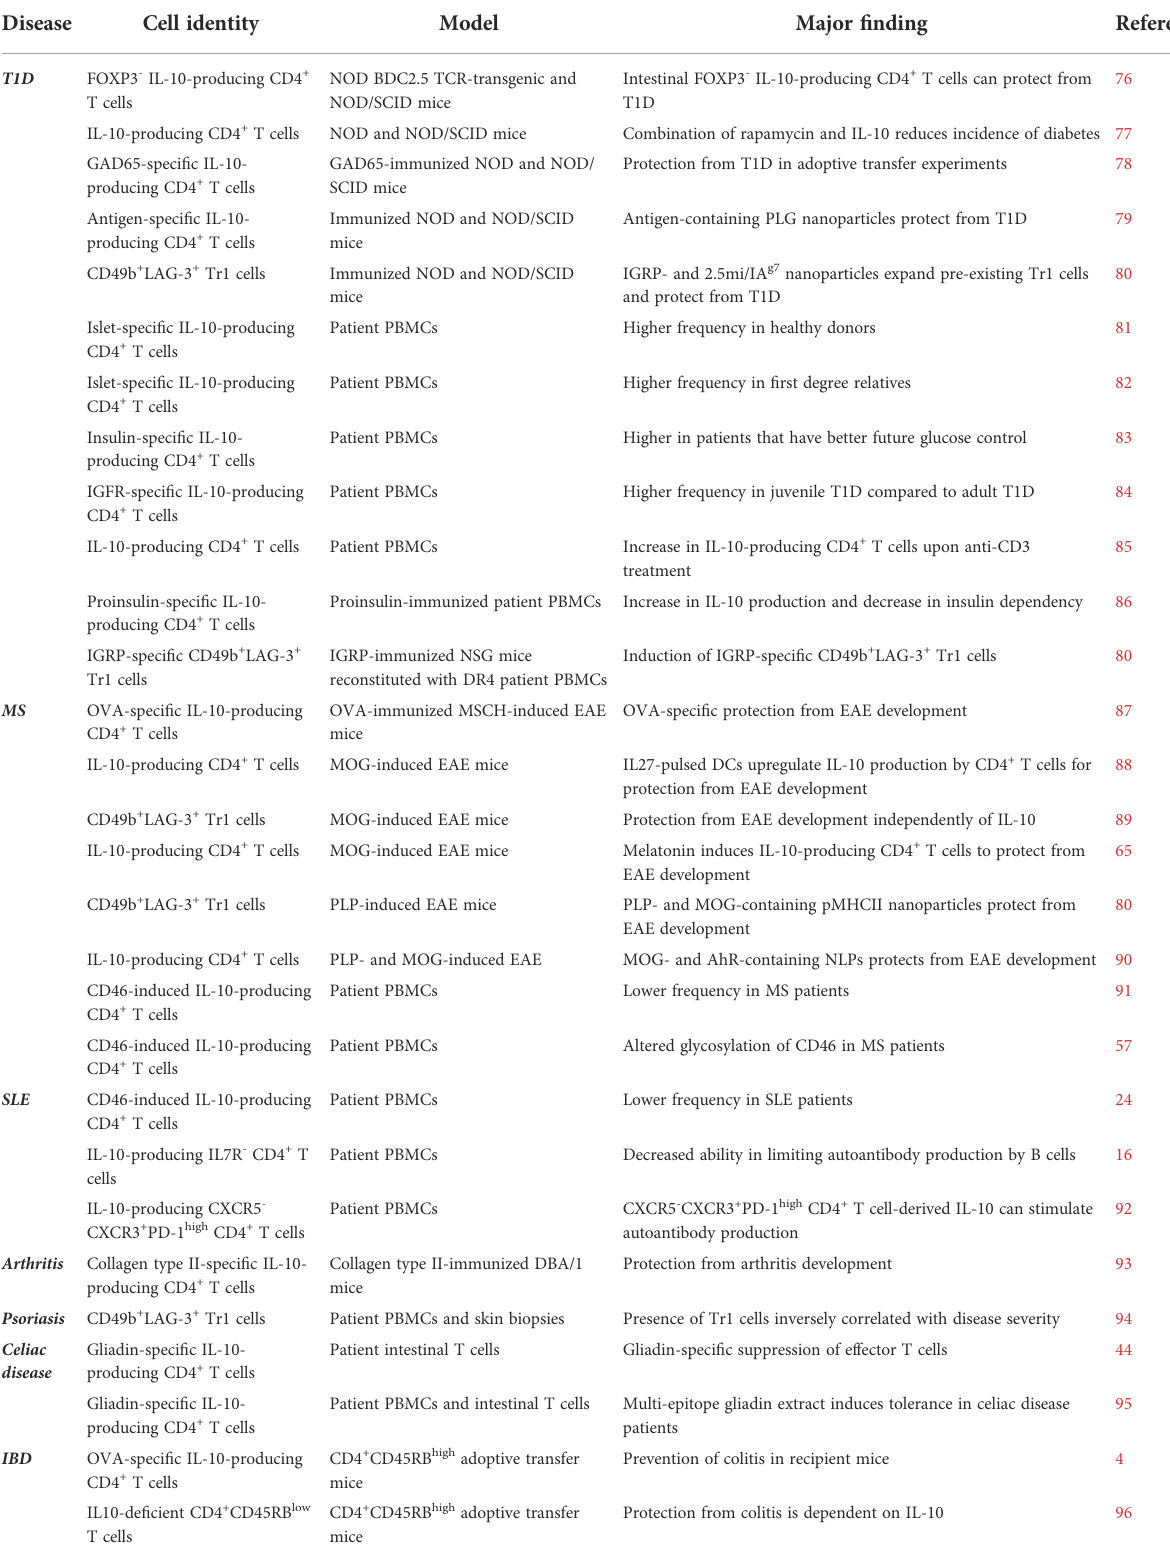
TABLE 1 Overview of the role of Tr1 and IL-10-producing CD4 + T cells in AIDs and IBD.